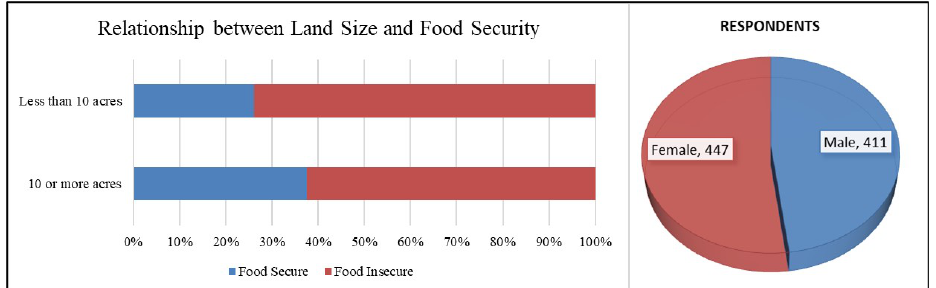
Figure 11. Relationship between land size and food security and